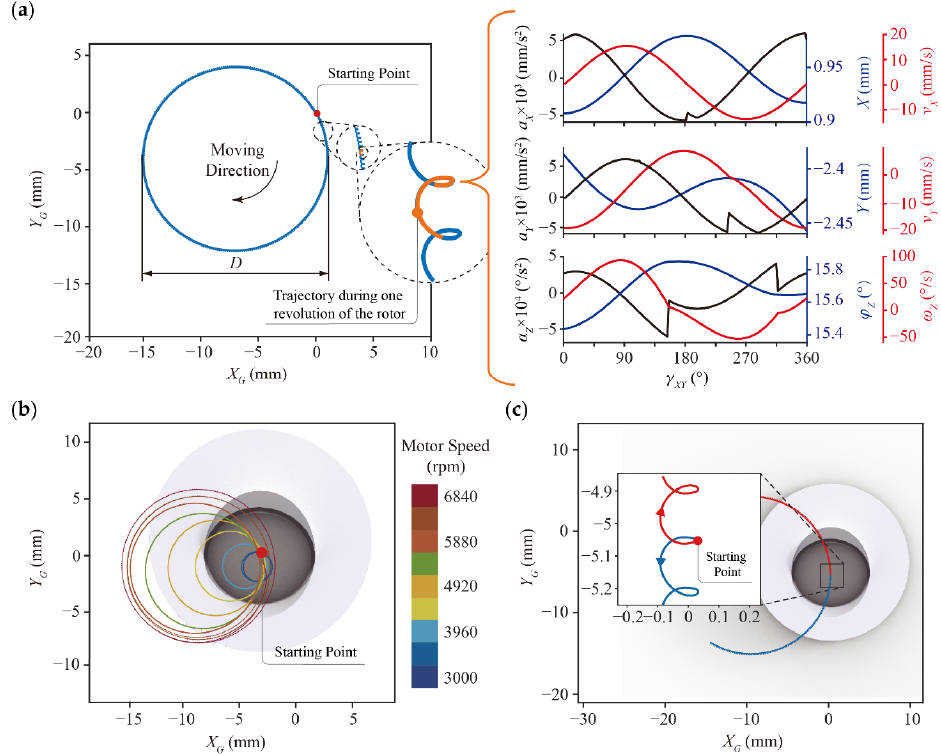
Figure 4. The movement of the robot on the X G Y G plane. ( a ) The trajectory circle generated by the robot while the rotor continuously spins at a constant speed. The orange spiral line is the trajectory during one revolution of the rotor. There is some parameter variance including the acceleration, velocity, and displacement on both X -axis and Y -axis, and the angular acceleration, angular velocity, and rotational angle along the Z -axis. ( b ) The corresponding trajectories of the robot under different motor speed. ( c ) The blue and red arcs represent that the robot’s motor is driven by positive and negative voltage and the robot rotates in counterclockwise and clockwise directions, respectively.